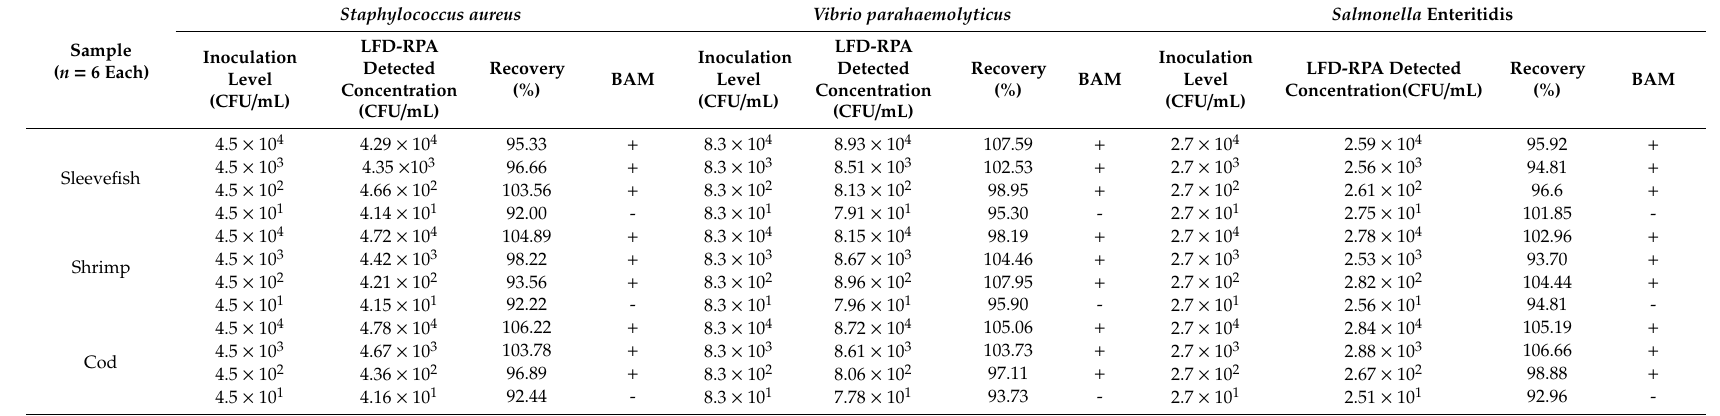
Table 3. The recoveries of Staphylococcus aureus , Vibrio parahaemolyticus and Salmonella Enteritidis in spiked food samples by multiple LFD-RPA.